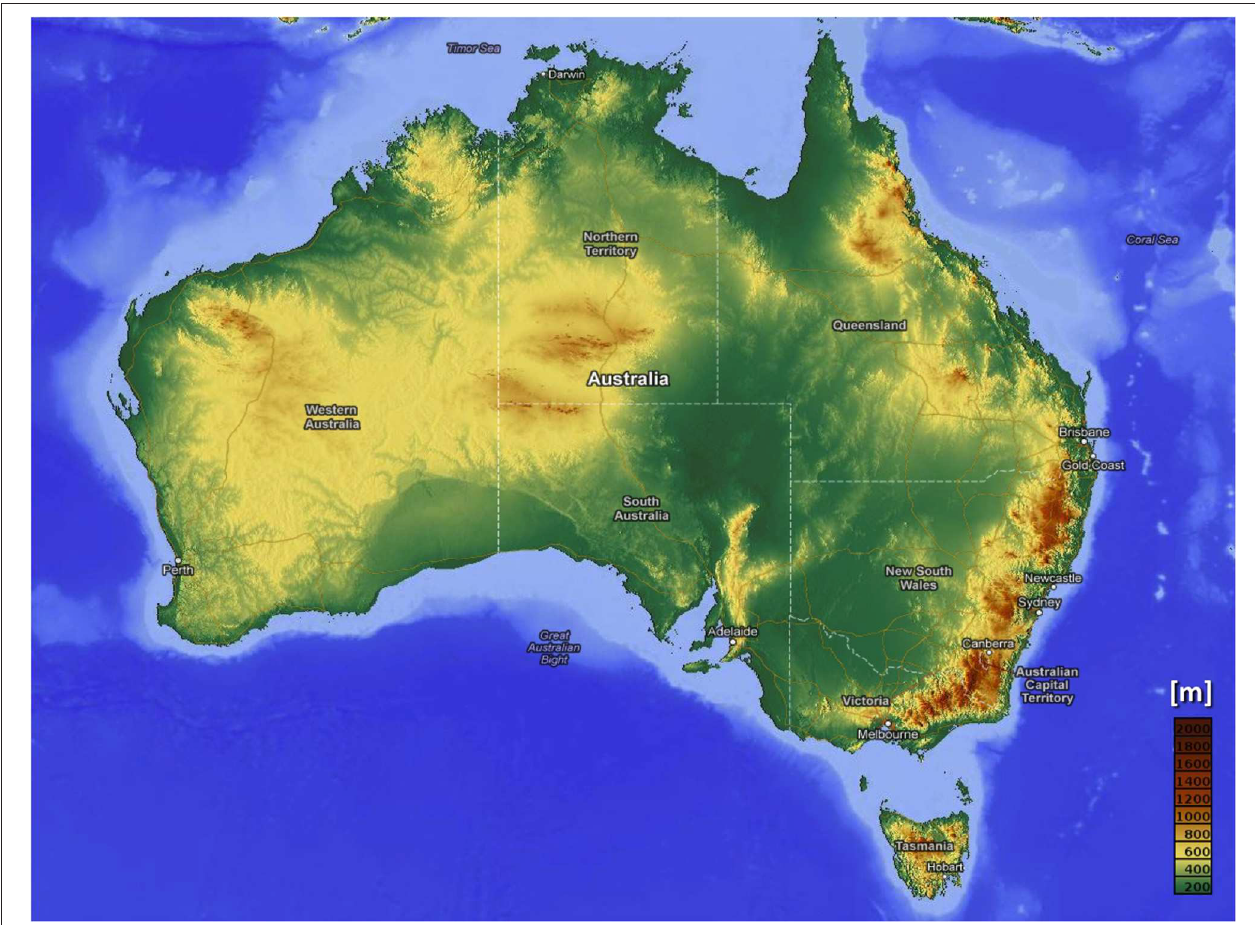
FIGURE 1 | Australia’s topography. The darkest browns are 2,000m above sea level. Source: https://i.imgur.com/6Ro7UFE.png.